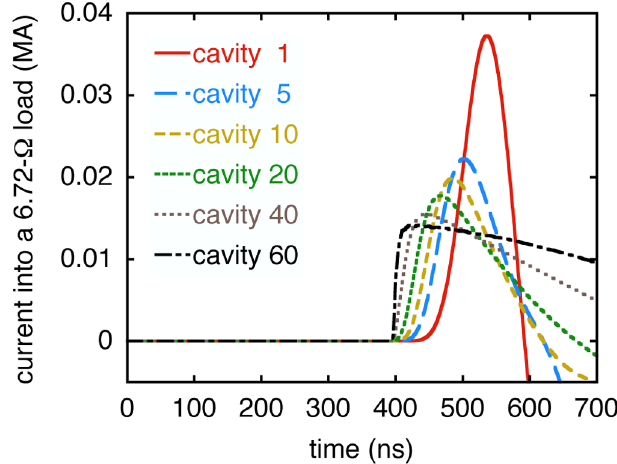
FIG. 6. (Color) The current pulses produced by six cavities of a 60-cavity LTD module. (The specific cavity timing indicated here is that which is produced by timing-sequence A.) Each of the five shapes plotted by Fig. 4 is a linear combination of 60 time-shifted pulses, each of which is produced by one of the module’s 60 cavities.